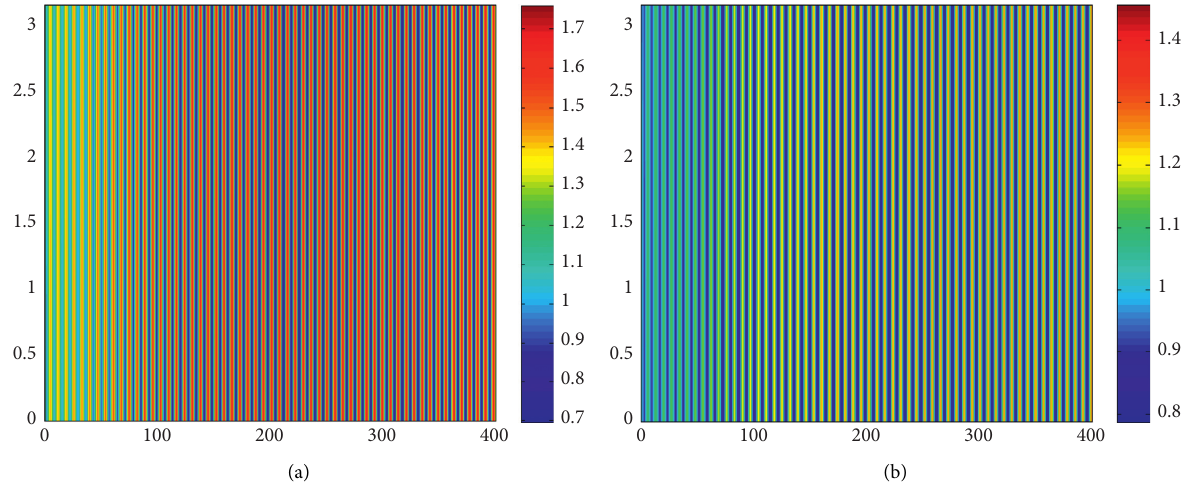
Figure 4: The spatial pattern of the system with Neumann boundary for τ ( t,x ) . (b) Spatial pattern of y of y 1